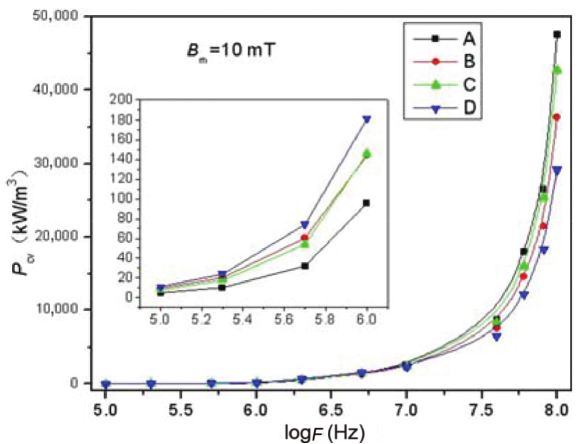
Figure 6: The relationship between power loss ( P cv ) and frequency at 10mT.